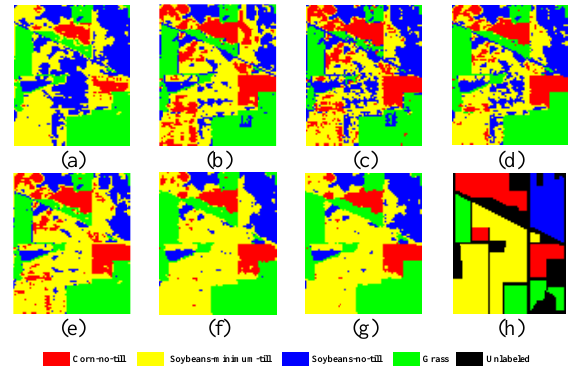
Figure 1. The clustering results on Indian Pines image: (a) CFSFDP, (b) FCM_S1, (C) SSC, (d) S 4 C, (e) KSSC, (f) SSC- SMP, (g) KSSC-SMP, (h) ground truth.